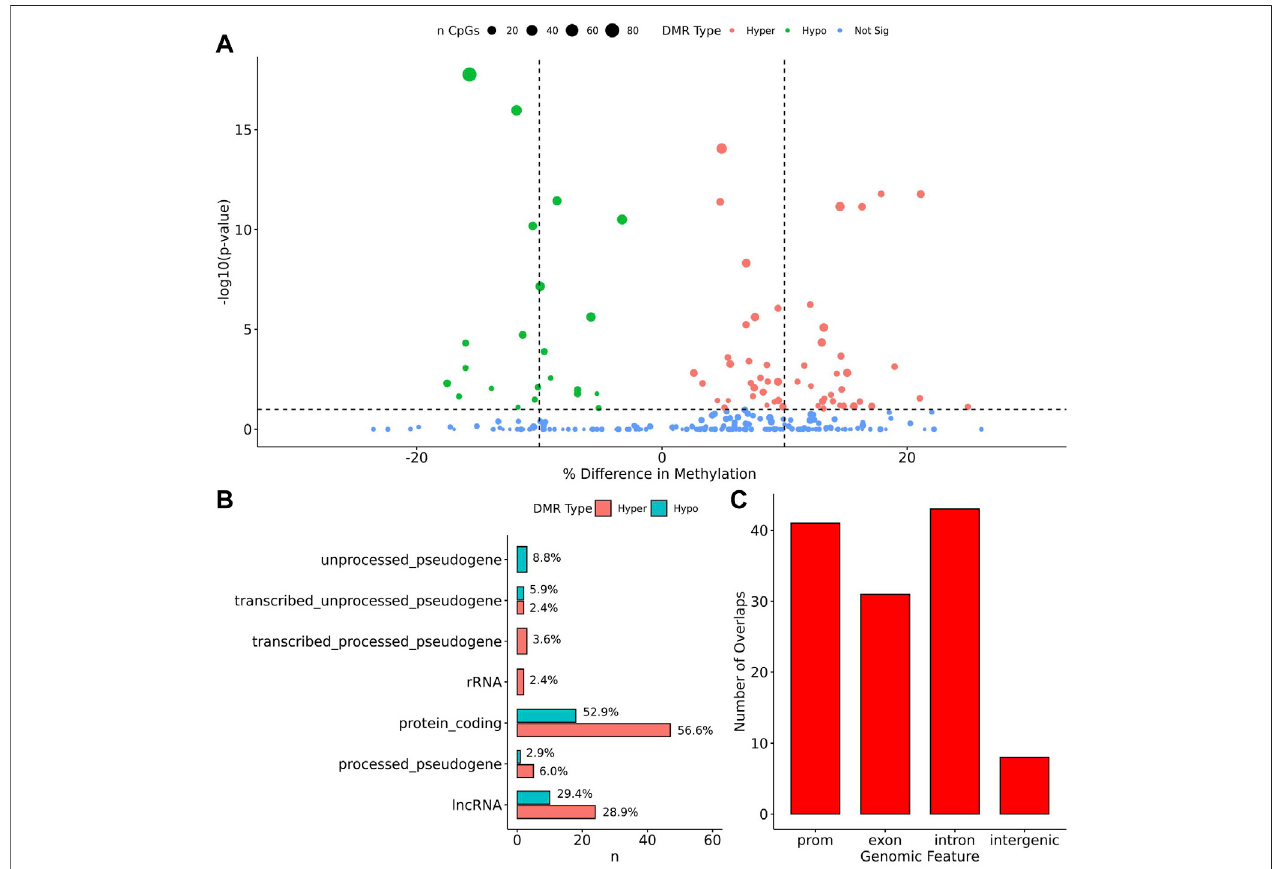
FIGURE2| 76DMRsweredetectedinTSBAVmostlynearproteincodingregions. (A) VolcanoplotofallregionsdetectedcoloredbyDMRtype,hypermethylated, hypomethylated, or not signi fi cant with dashed lines at − log10 (0.1) and ±10% methylation difference. (B) Barplot of gene type annotations for all genes overlapping DMRs or the nearest gene when DMRs lack overlap. (C) Barplot of promoters, exon, intron, and intergenic regions overlapping